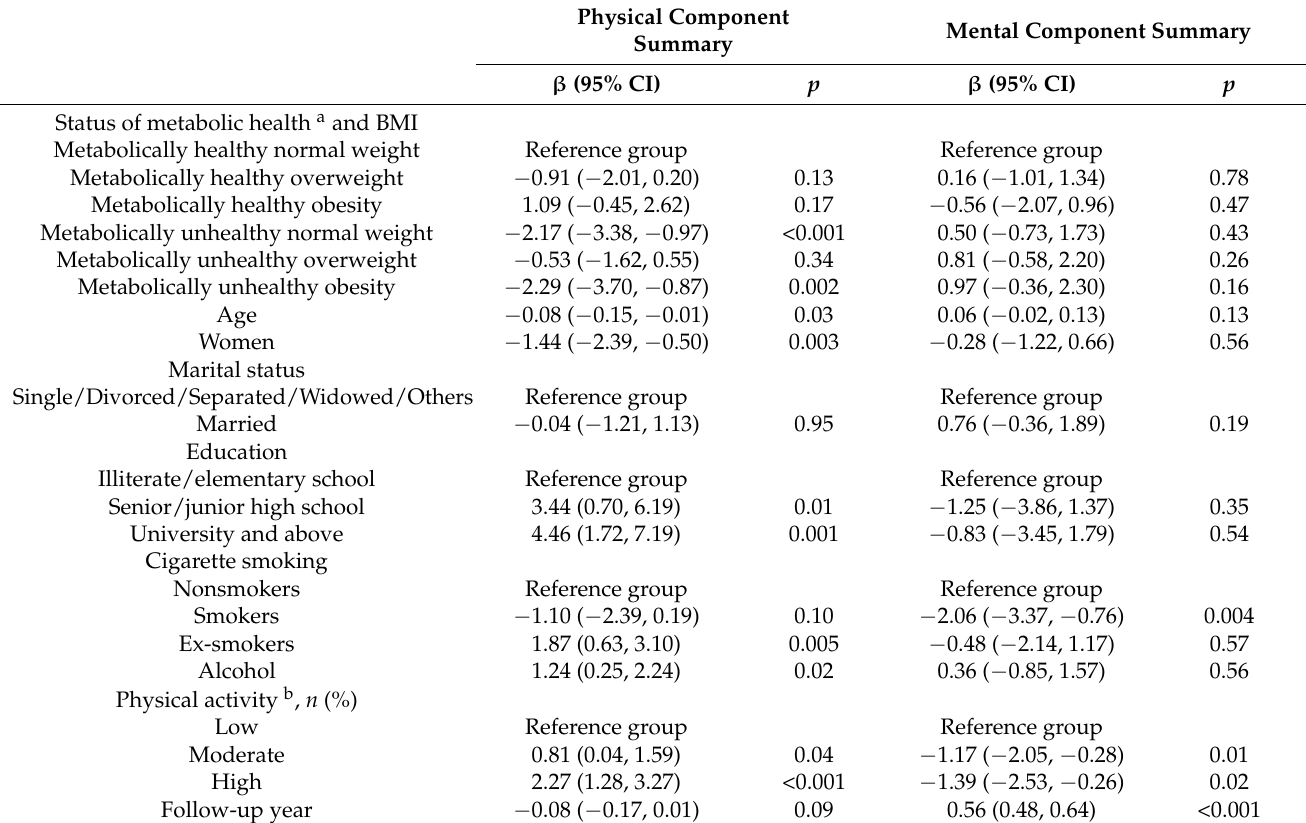
Table 2. The association between metabolic health/BMI groups and health-related quality of life. Physical Component